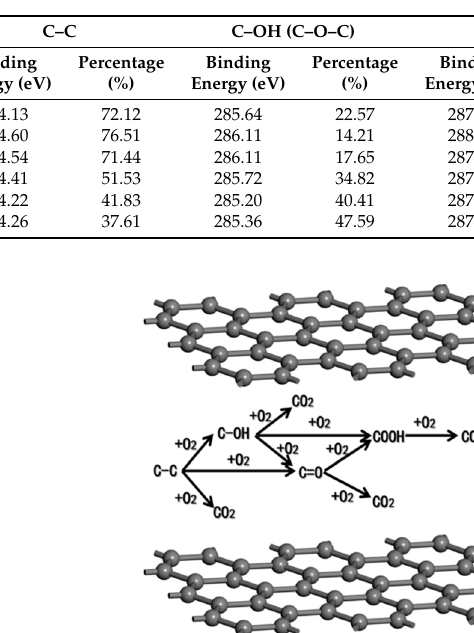
Table 5. Surface functional groups of control and exposed carbon fibers determined by XPS.